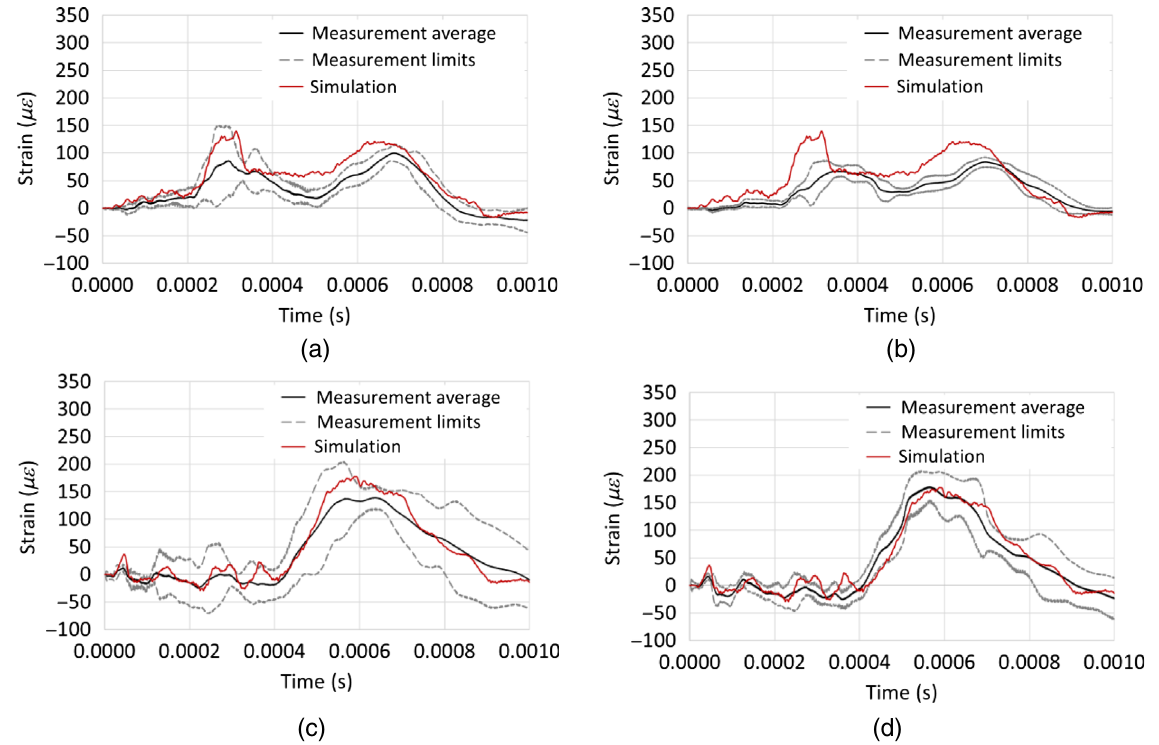
FIG. 13. Dynamic strain responses at the front corner of the target. (a) Sensor D (left-beam direction). (b) Sensor X (right-beam direction). (c) Sensor V (left-transverse direction). (d) Sensor W (right-transverse